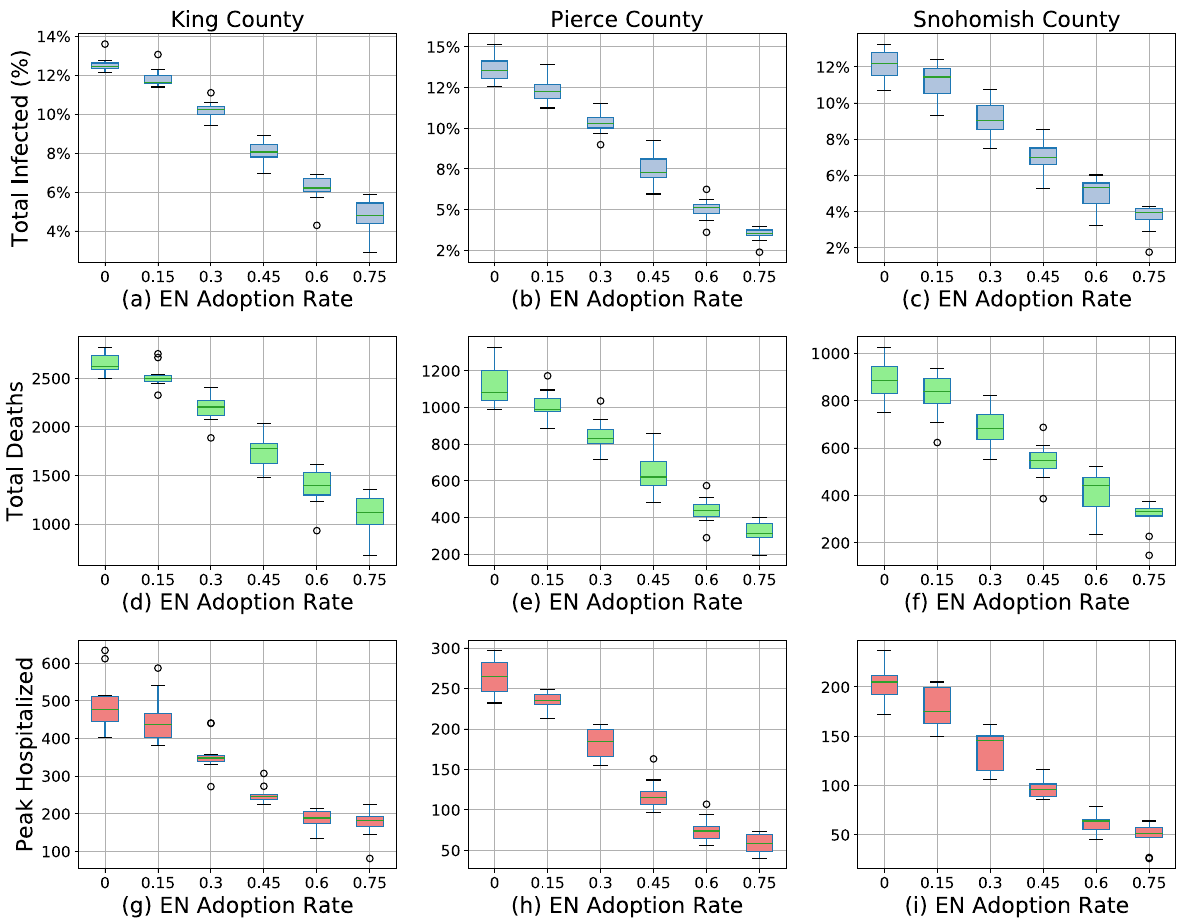
Fig. 2 Peak metrics vs exposure noti fi cation adoption rates. Estimated total infected percentage ( a – c ), total deaths ( d – f ), and peak in hospital ( g – i ) ( y -axes) of King ( a , d , g ), Pierce ( b , e , h ), and Snohomish ( c , f , i ) counties for various levels of exposure noti fi cation (EN) app uptake among the population ( x -axis) between July 11, 2020 and December 25, 2020. The boxes represent the Q1 to Q3 quartile values with a line at the median. The whiskers show the range of the data (1.5 * (Q3 – Q1)) and any outlier points are past the end of the